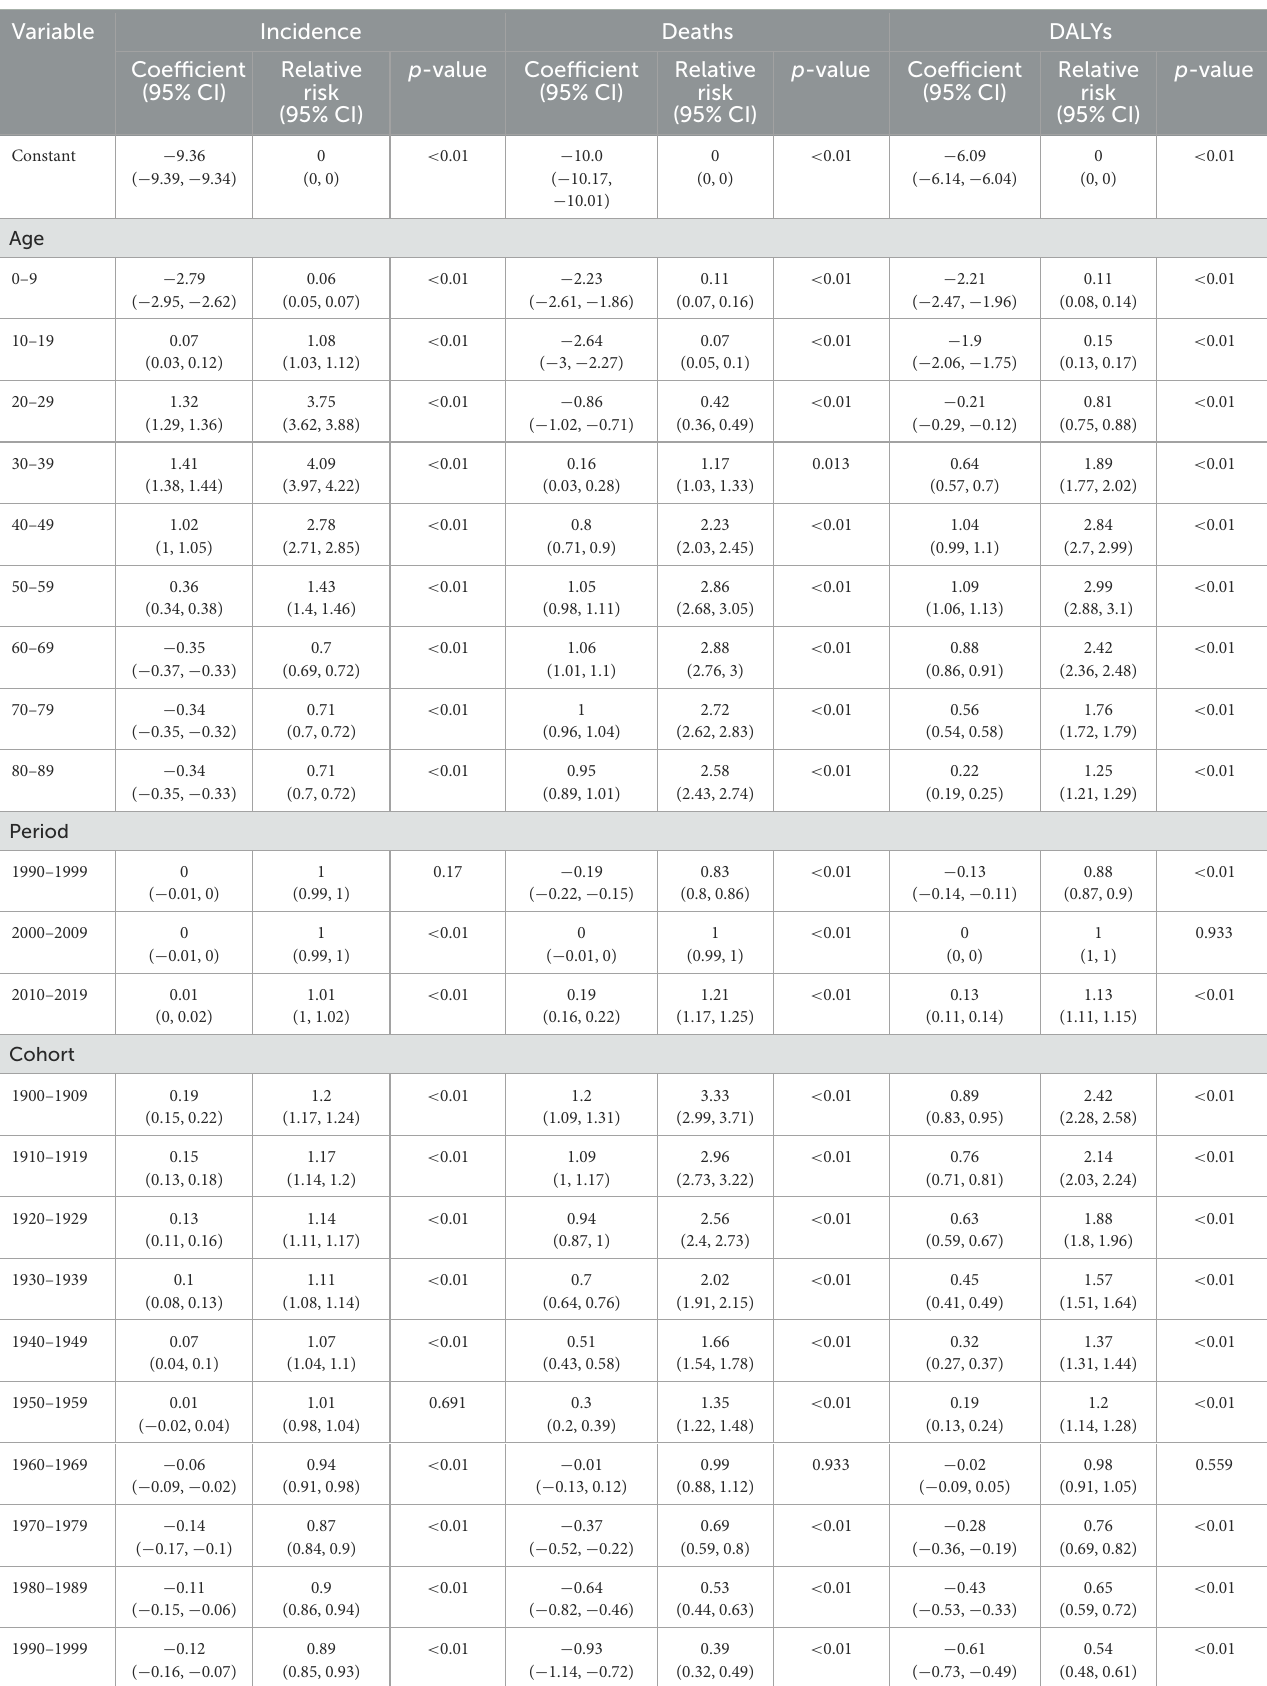
TABLE 4 The age, period, and cohort effect on the global incidence, death, and DALYs rate of multiple sclerosis. Variable Incidence Deaths